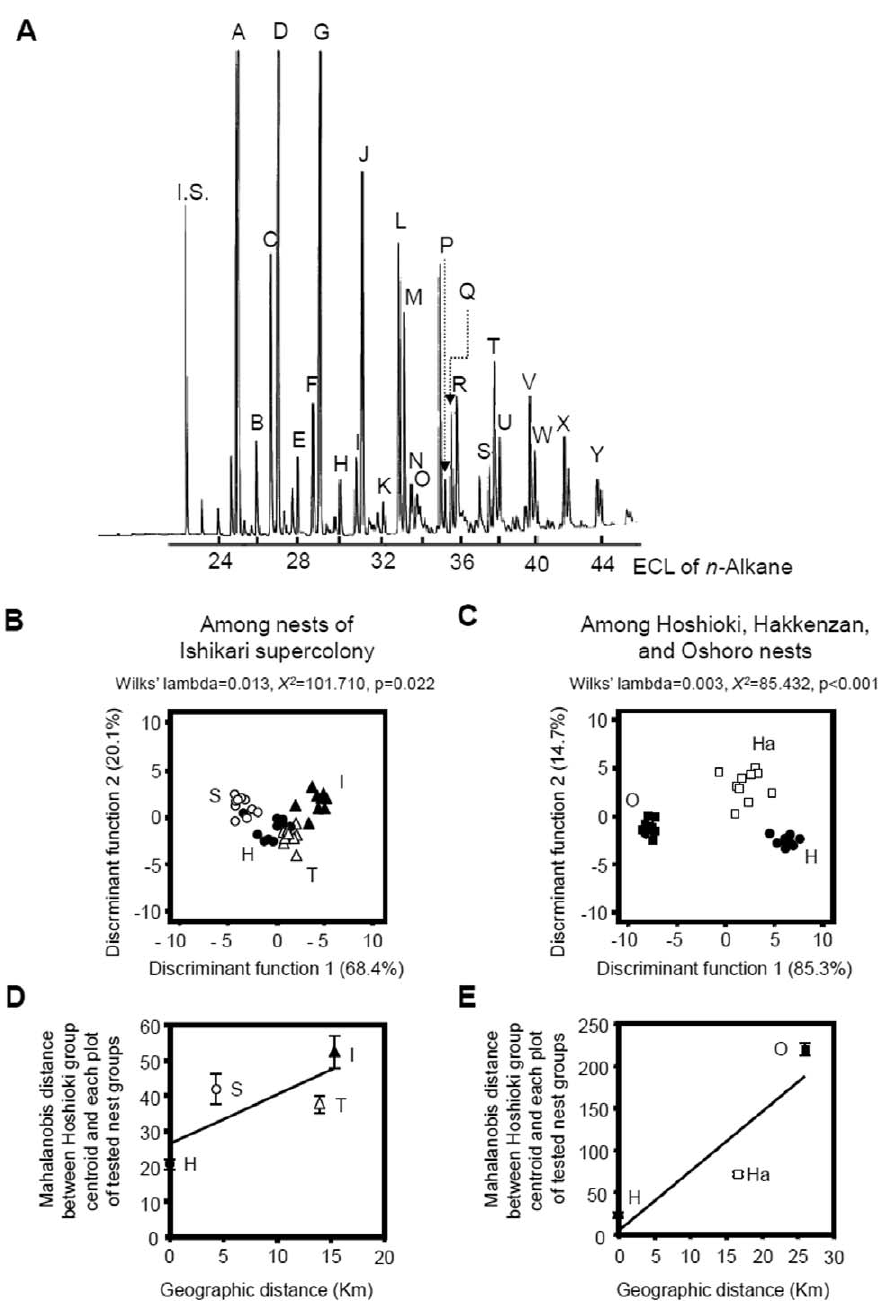
Figure 2. Characteristics of CHC composition of F.yessensis . ( A ) Gas-chromatogram of CHCs of F. yessensis . ( B ) Discriminant analyses of individual CHC profiles among four nests within the ‘‘Ishikari supercolony’’; ( C ) Discriminant analyses of individual CHC profiles among three independent nests: ‘‘Hoshioki’’ (H) within and ‘‘Oshoro’’ (O) and ‘‘Hakkenzan’’ (Ha) outside the ‘‘Ishikari supercolony’’. ( D ) Correlation between geographic distance and the Mahalanobis distance (average 6 SE) between the 4 nests within the ‘‘Ishikari supercolony’’; ( E ) Correlation between geographic distance and the Mahalanobis distance (average 6 SE) between the three independent nests. For the discriminant analyses in (B) and (C) we used 24 peaks (A-X) that were commonly detected in all tested individuals, but omitted the 25th compound, Y, having a too high molecular mass to be chemically identified (see Table 1). The straight lines in (D) and (E) are regression lines drawn by the least-squares method.